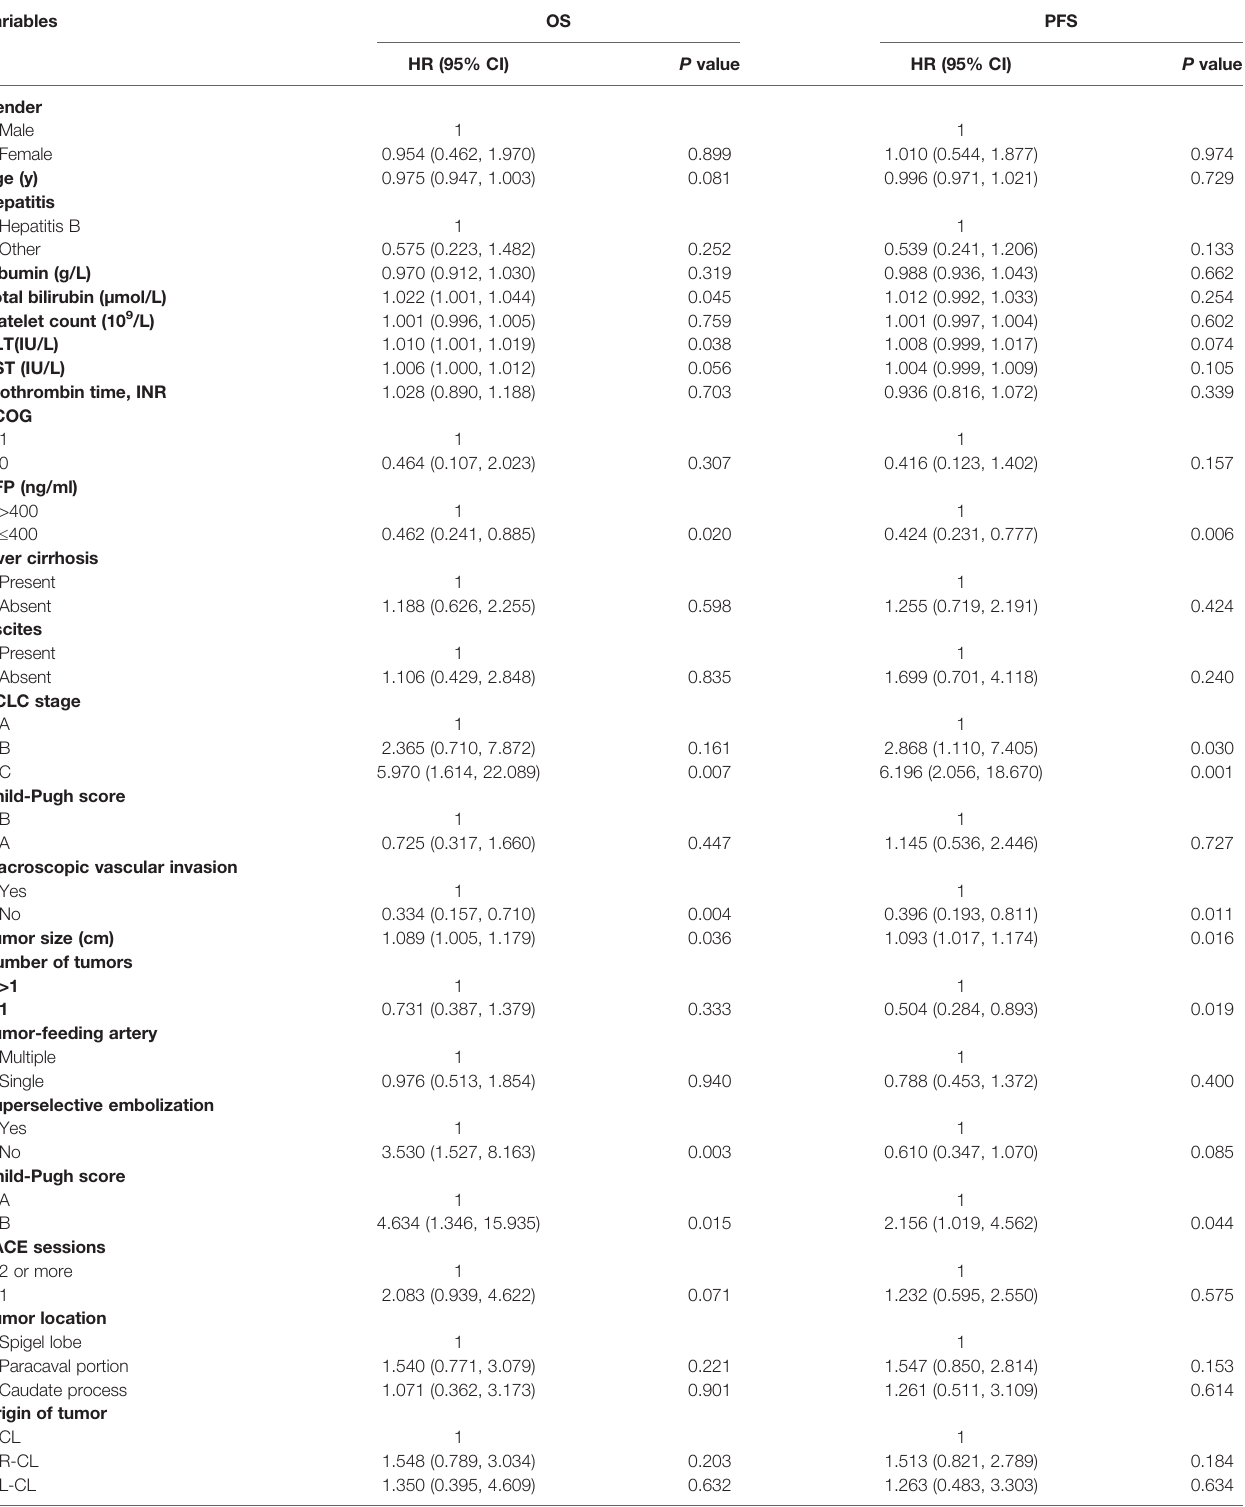
TABLE 2 | Univariate analysis of prognostic factors for overall survival (OS) and progression-free survival